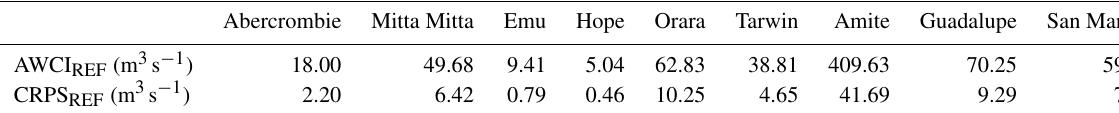
Table 3. AWCI and CRPS calculated from the reference forecast for each catchment.